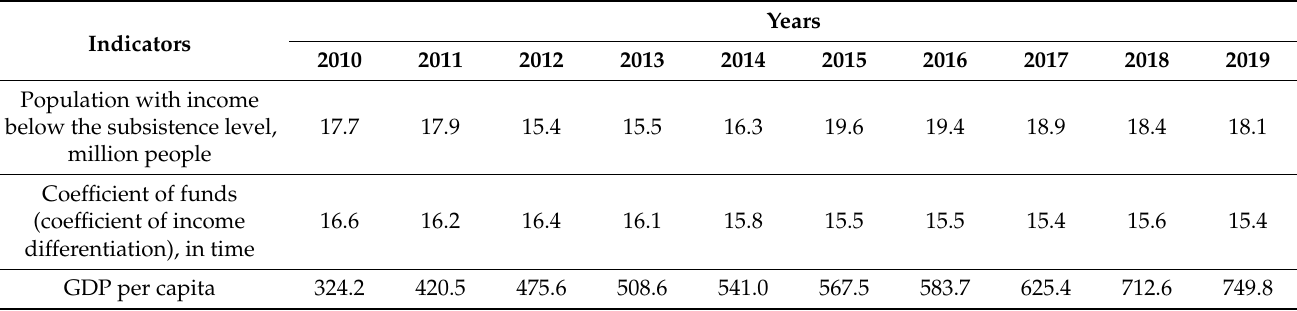
Table 1. Main indicators characterizing the macro-regional block “Income” in the Russian Federation for 2010–2019.